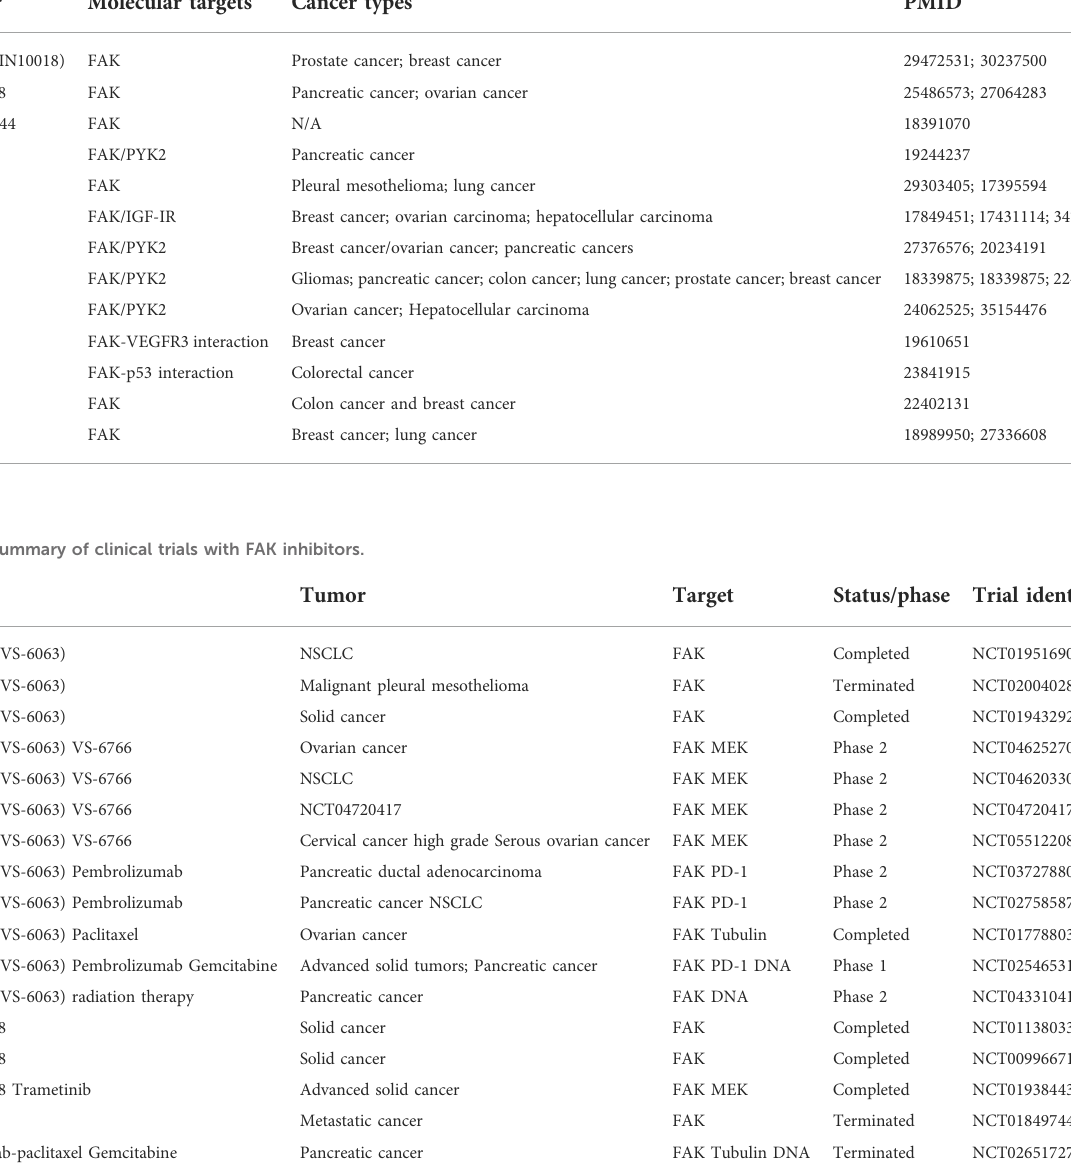
TABLE 2 Summary of preclinical studies with FAK inhibitors.